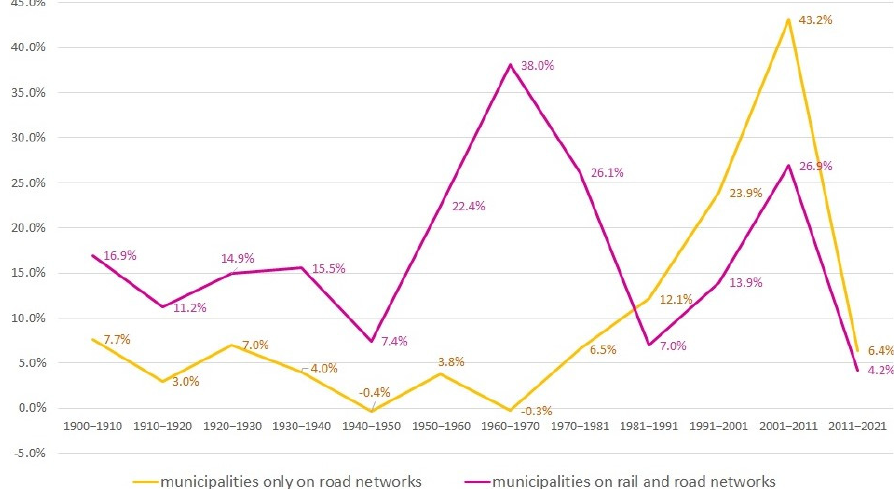
Figure 7 Figure 7. Percentage increases in population compared to the beginning of each